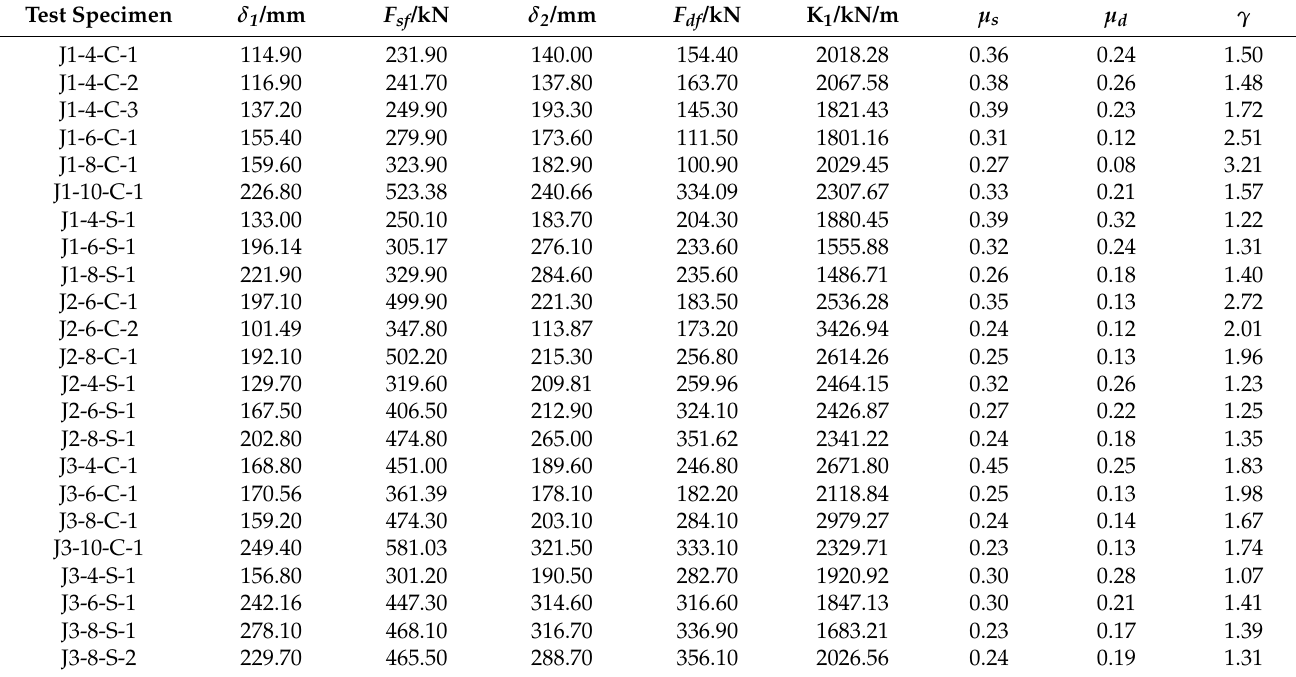
Table 3. Statistics of LRB sliding response